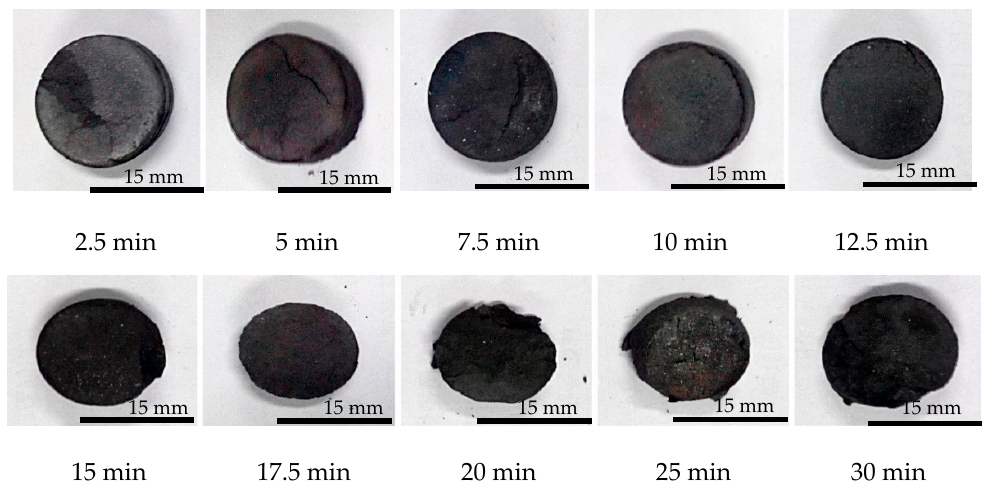
Figure 8. The macroscopic morphology changes of the reduced pellets at different times under vacuum condition.